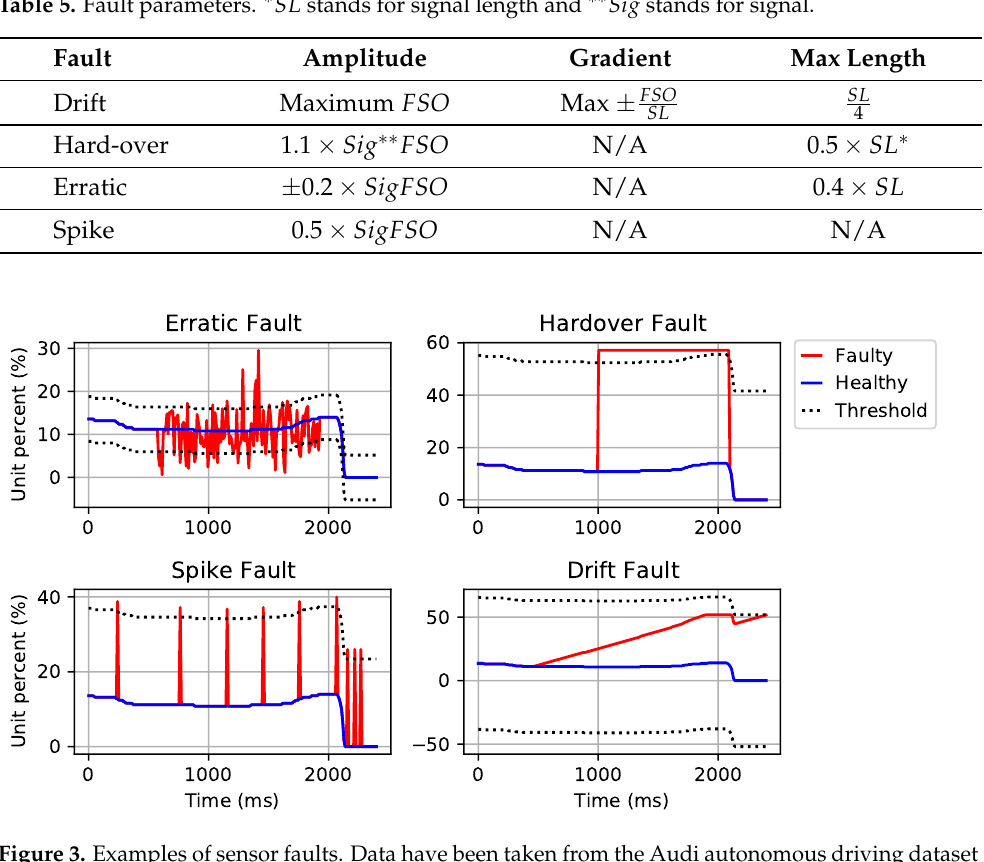
Figure 3. Examples of sensor faults. Data have been taken from the Audi autonomous driving dataset (A2D2). All four figures are faulty variants of a sample signal from the AccP